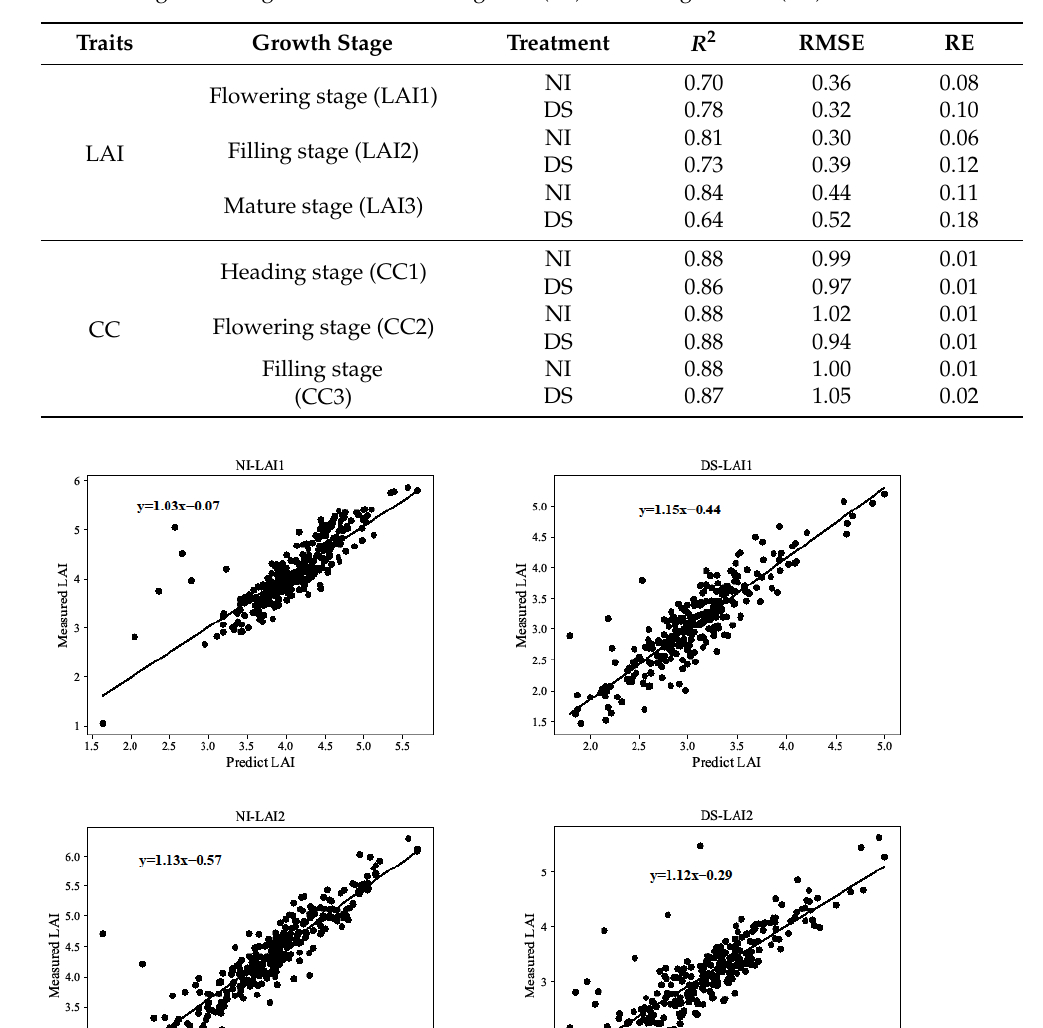
Table 2. Determination coefficient ( R 2 ), root-mean-square error (RMSE), and relative error (RE) of the algorithm for modeling the estimation of leaf area index (LAI) and chlorophyll content (CC) of wheat at different growth stages under normal irrigation (NI) and drought stress (DS) conditions. Traits Growth Stage